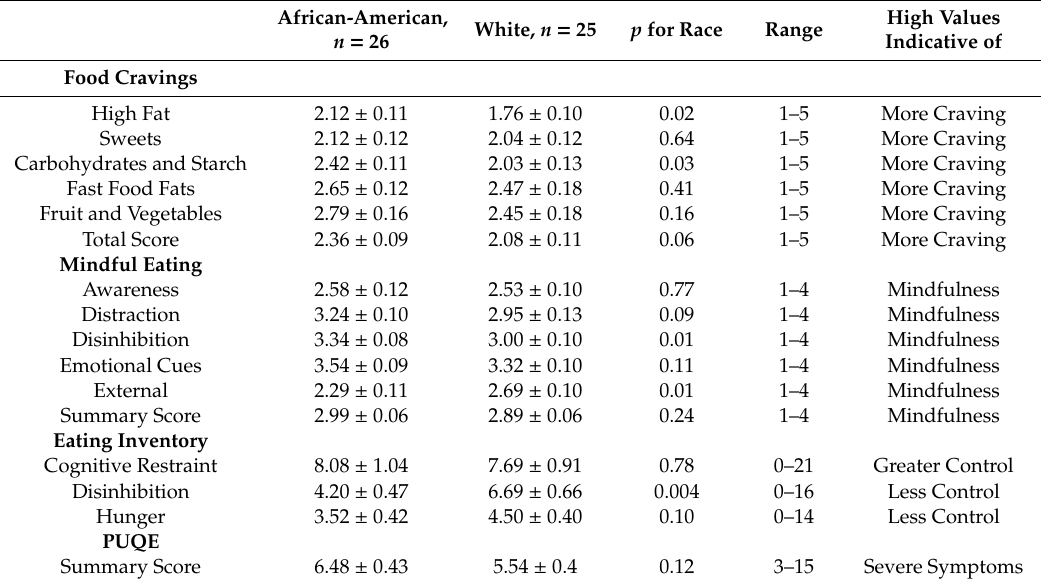
Table 2. Eating Behavior